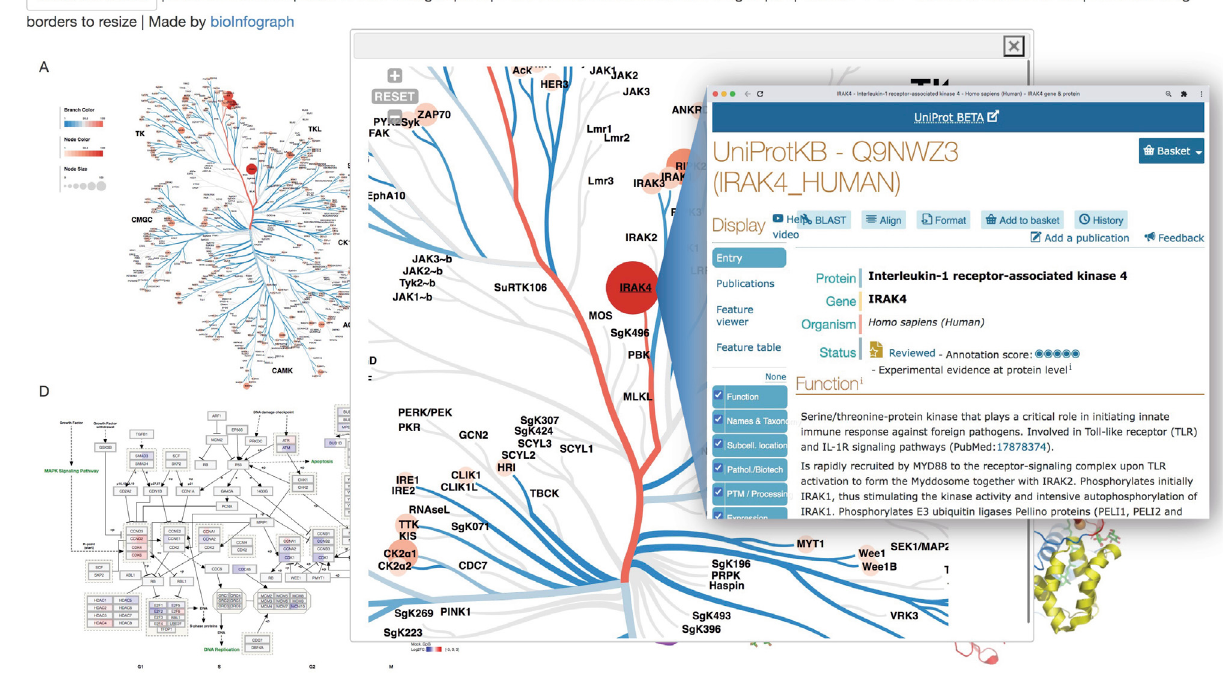
FIGURE7| InteractiveonlineHTMLpresentationof Figure1 withzoom-inandlink-outfeatures.Clickingonanindividualplotwillbringupapopupwindowwiththe enlargedzoomableversion.LinksinScalableVectorGraphics(SVG)areactive,soclickingon “ IRAK4 ” onthenodeinthephylogenetictreewillshowdetailedinformation about the protein in UniProt database.